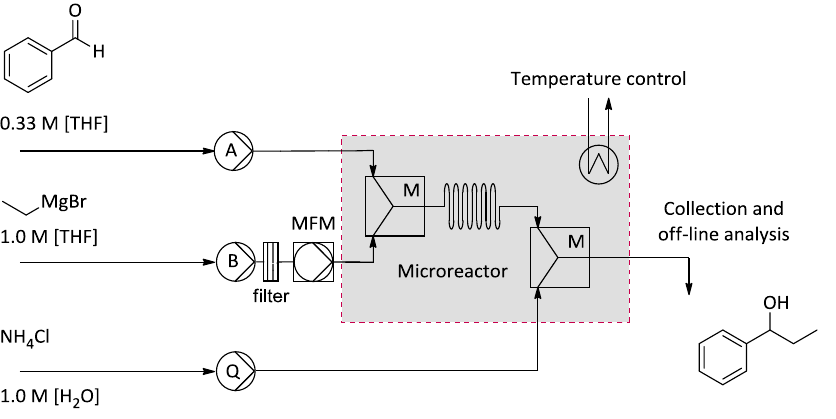
Figure 8. Schematic setup for the Grignard reaction with